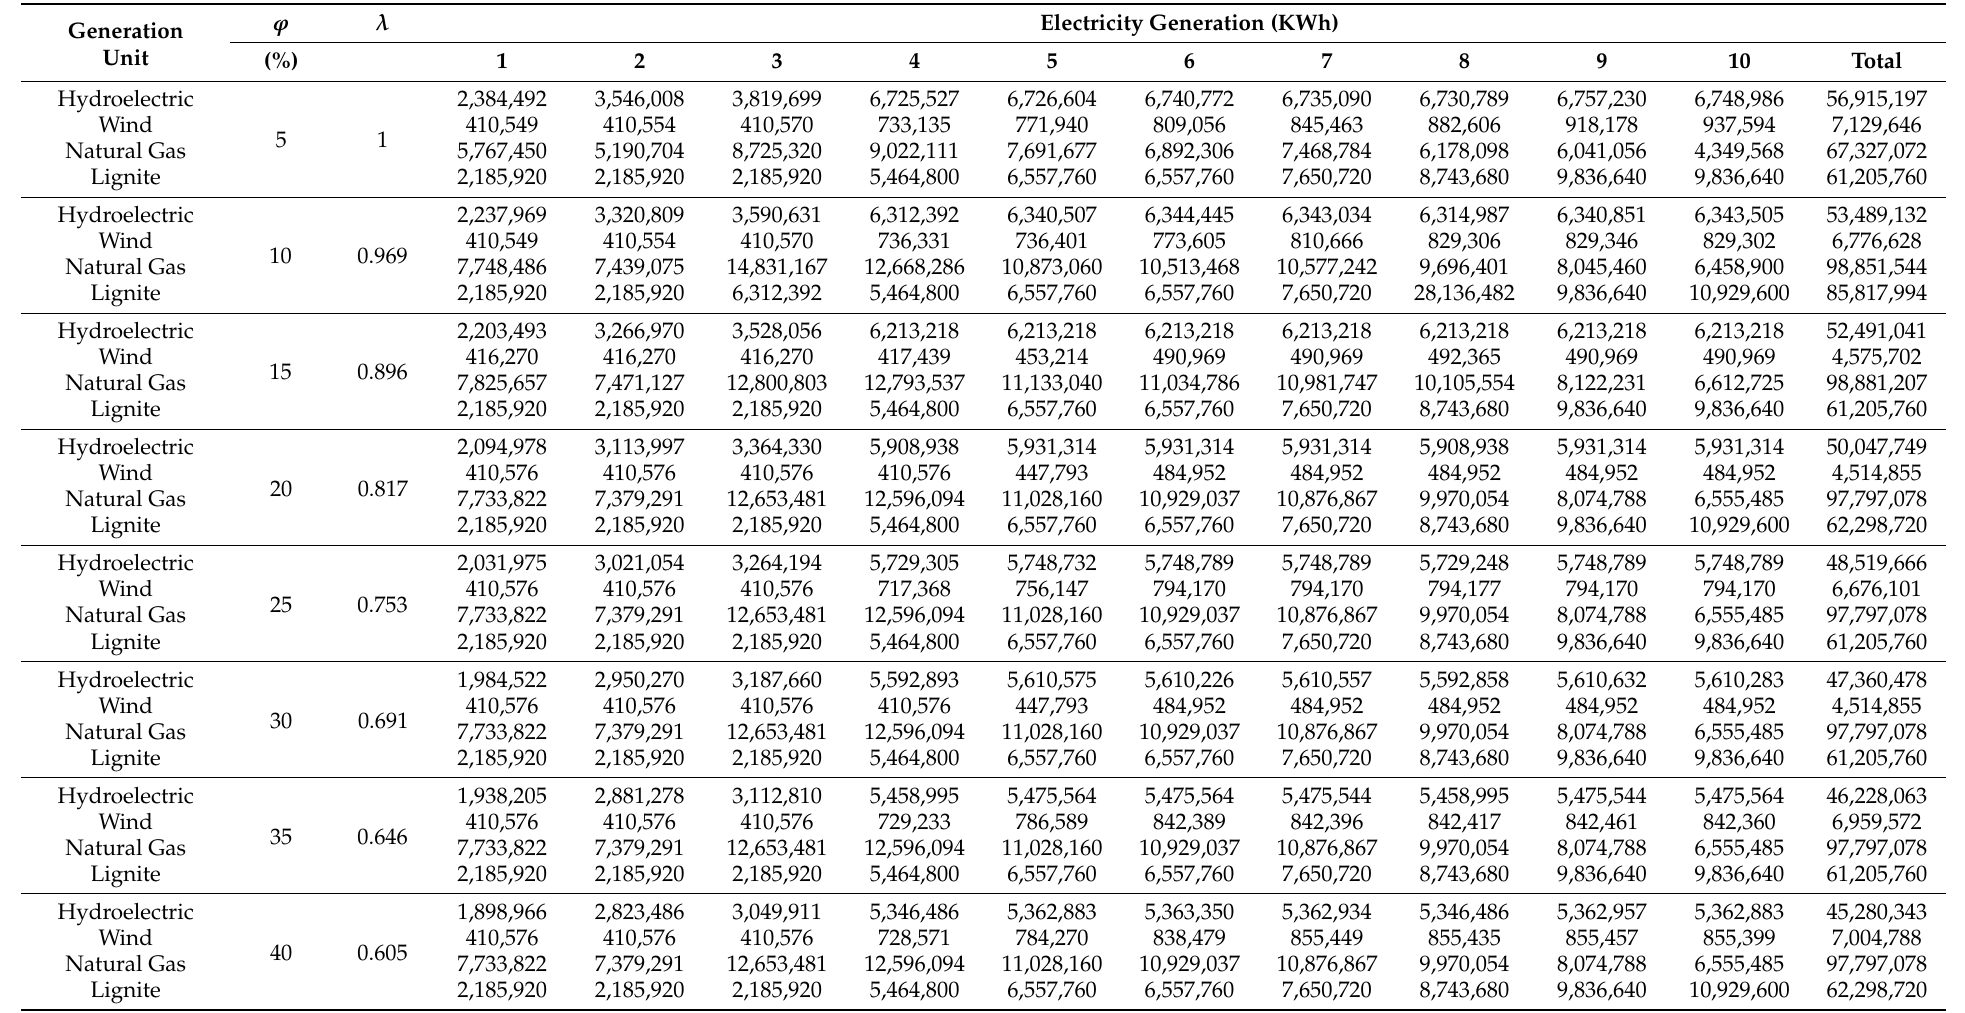
Table 6. The relationship between ϕ , λ , and the change in electric energy generation over the